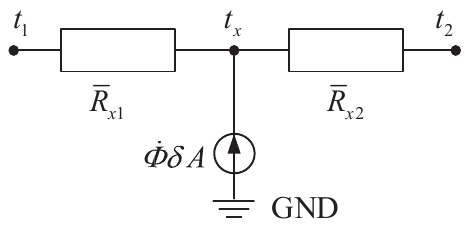
Figure 4. Heat conduction within the heat